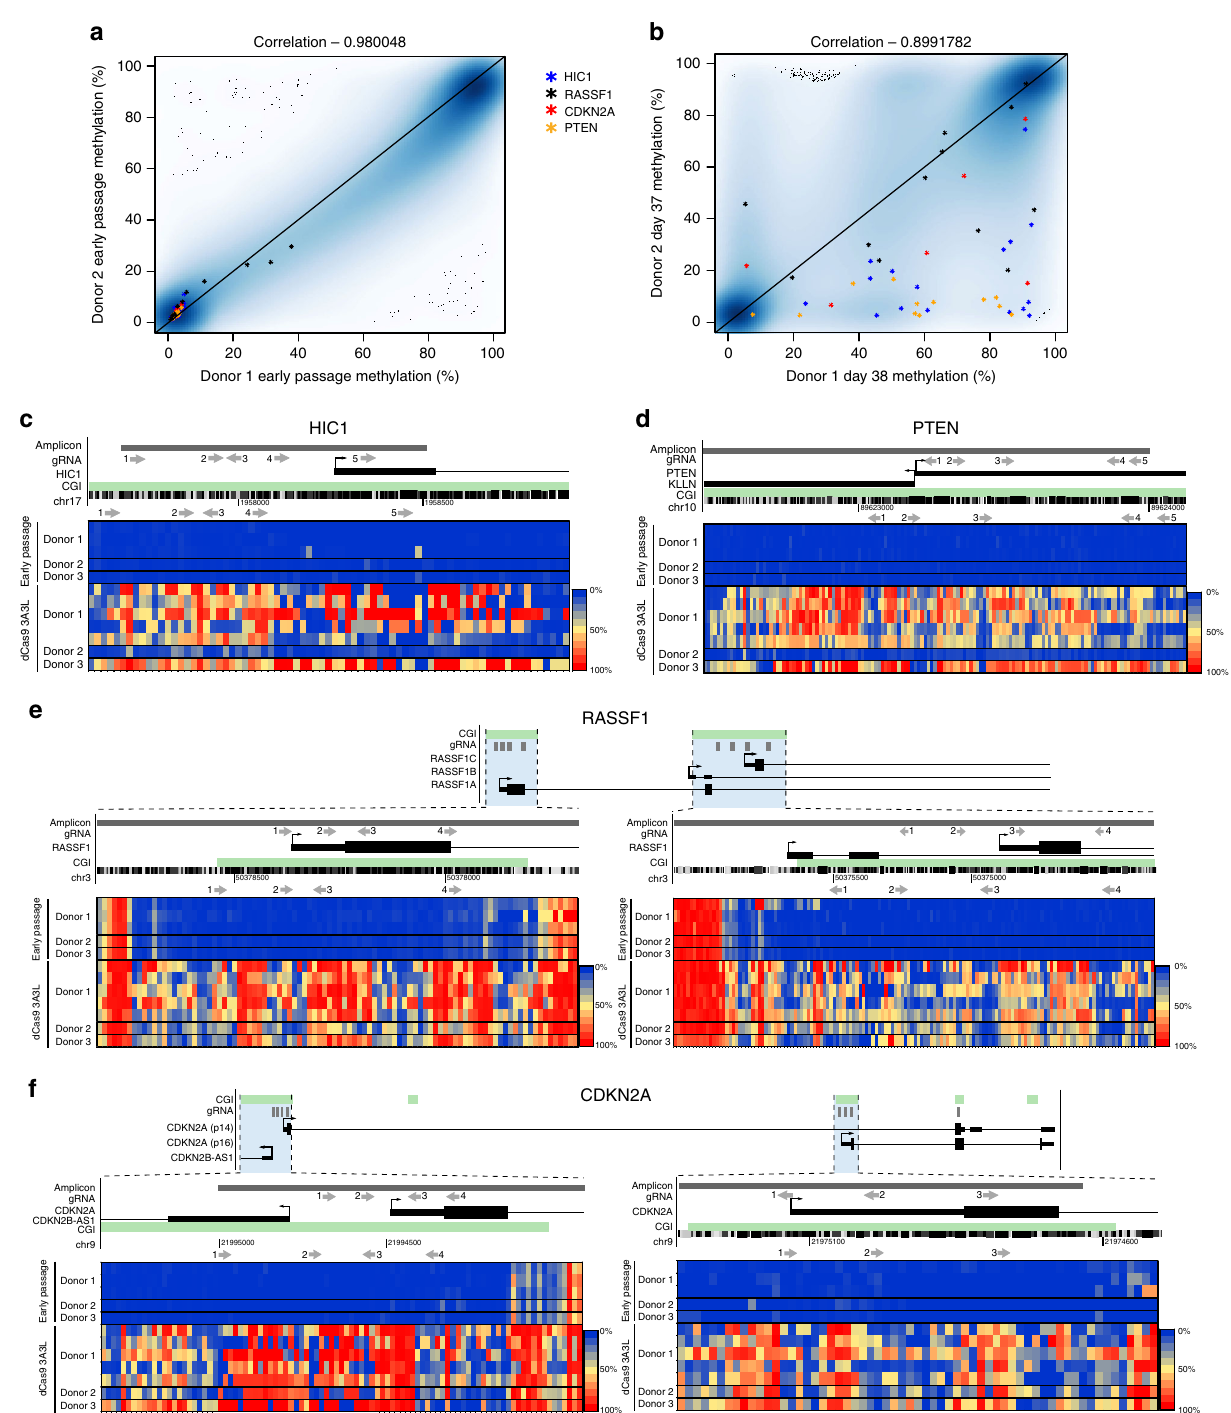
Fig. 4 DNA methylation is consistently maintained at HIC1 , RASSF1 and CDKN2A . a Scatter plot of DNA methylation from all EPIC array probes comparing donor 1 and donor 2 early passage primary myoepithelial cells ( n = 1). The probes from the target genes highlighted on the plot are those that were found to be signi fi cantly hypermethylated at day 10 after dCas9 3A3L vs. 3A3L Δ targeting as shown in Fig. 2e. b Scatter plot of DNA methylation from all EPIC array probes comparing donor 1 and 2 primary myoepithelial cells 38 and 37 days respectively after targeting dCas9 3A3L to HIC1 , PTEN , RASSF1 and CDKN2A . The same probes from a are highlighted ( n = 1). c – f Targeted bisul fi te sequencing at c HIC1 , d PTEN , e RASSF1 and f CDKN2A . The localisation of the bisul fi te amplicon (dark grey bar) and gRNA (grey arrows pointing towards the PAM sequence) in relation to CGI (green bar) and TSS of genes is shown. Each rectangle represents the methylation % indicated by the colour key of a single CpG and each line is data from a single replicate. The top 5 lines show data from early passage (passage 2) primary myoepithelial cells from donors 1, 2 and 3, the bottom 7 lines show data from primary cells 37 – 41 days after transfection with dCas9 3A3L targeting HIC1 , RASSF1 , PTEN and CDKN2A . Top lines of data from donor 1 early passage and dCas9 3A3L targeted is from the same samples as the EPIC array data in Fig. 4a, b. Bisul fi te sequencing data from donor 2 is from the same samples as the EPIC array data shown in Fig. 4a,